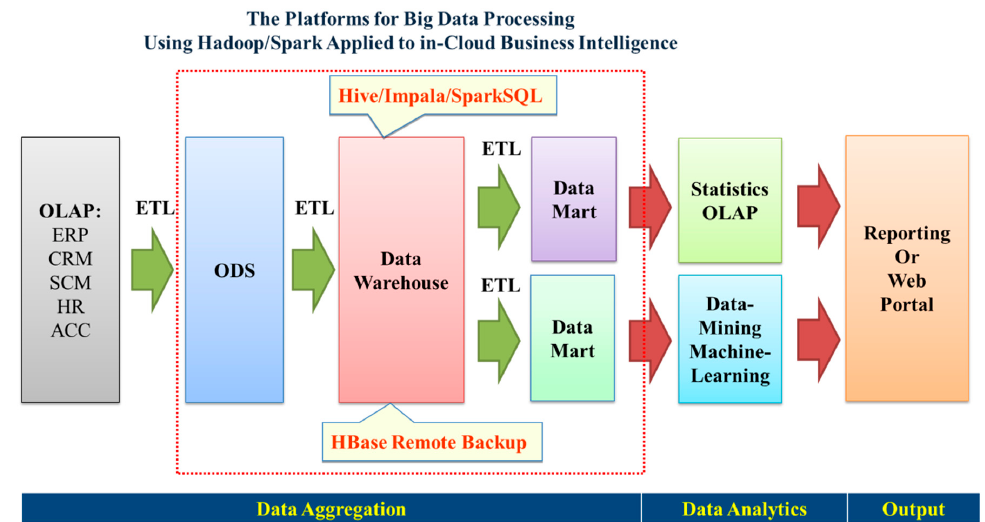
Figure 2. Business intelligence (BI) with multiple big data processing tools.